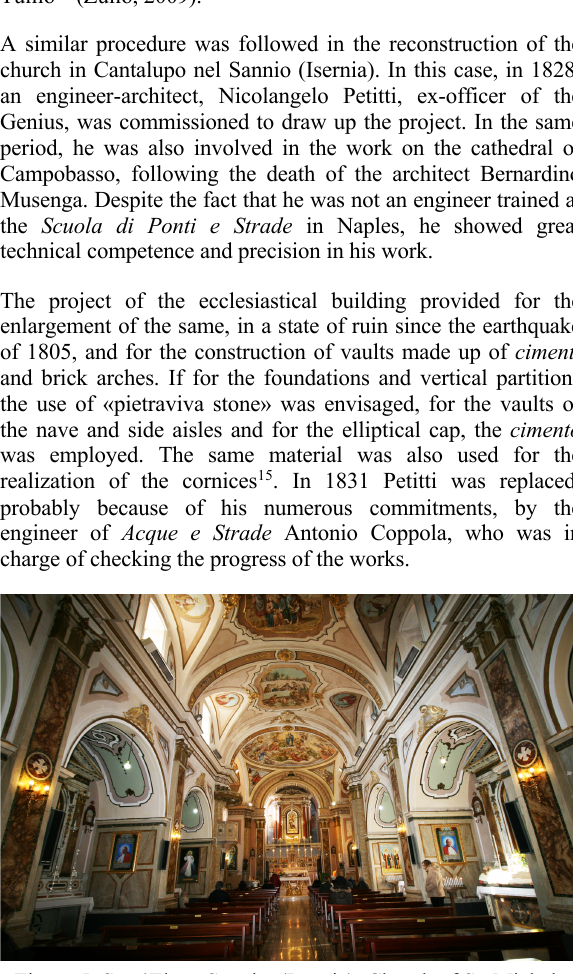
Figure 5. Sant’Elena Sannita (Isernia). Church of St. Michele Arcangelo: the main nave (Romano,